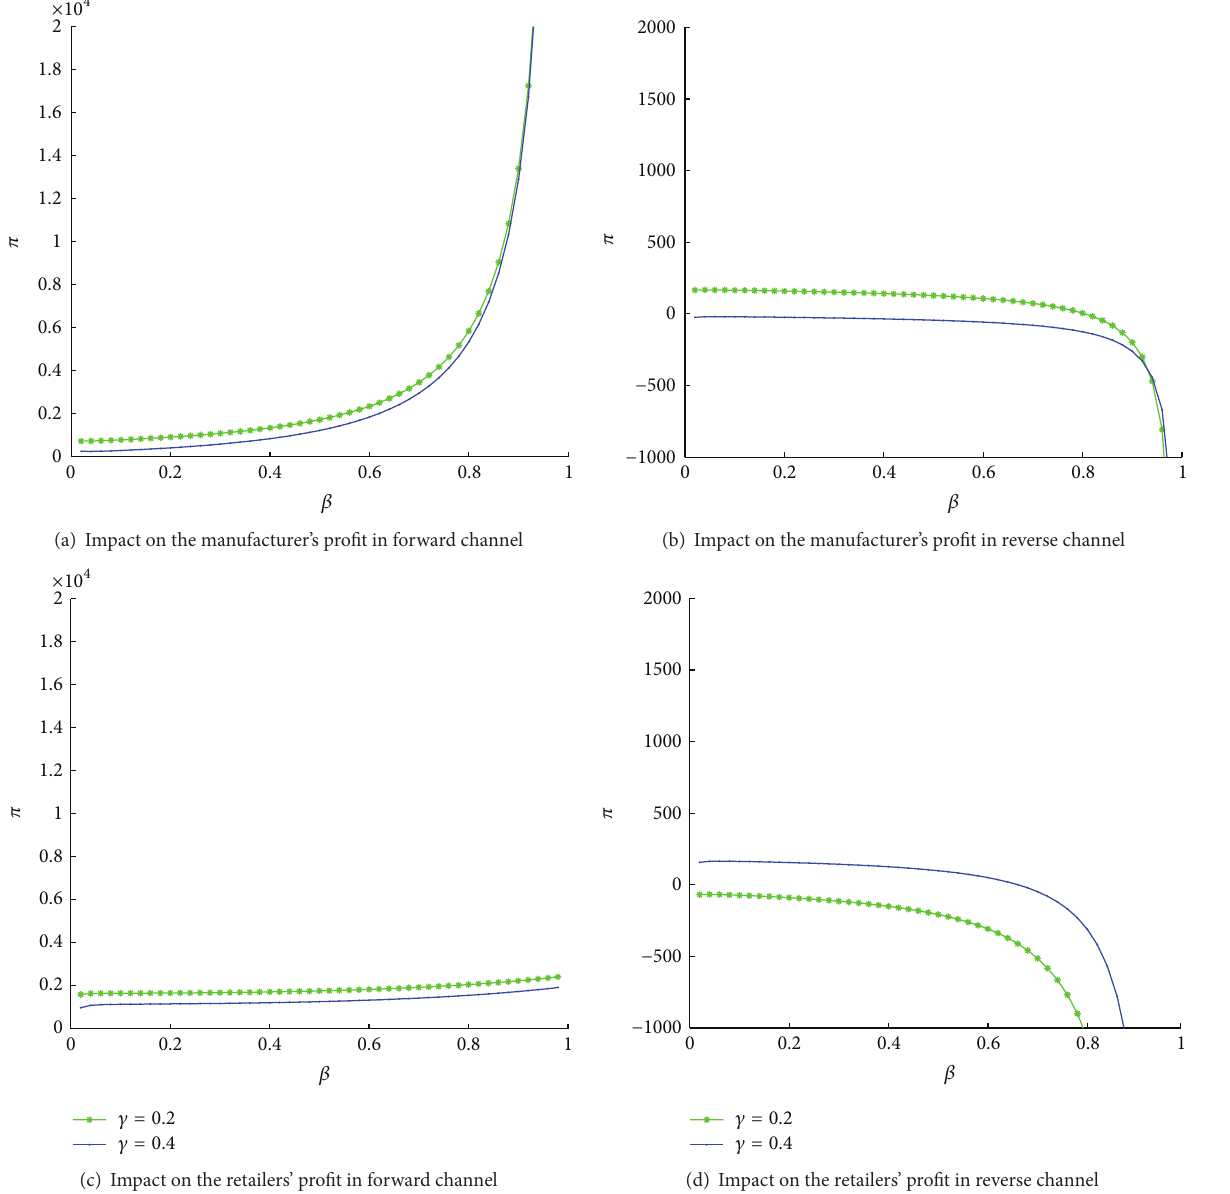
Figure 5: Impact of the retailing and recycling substitution effects on channel profit in model 𝐷𝐶 .